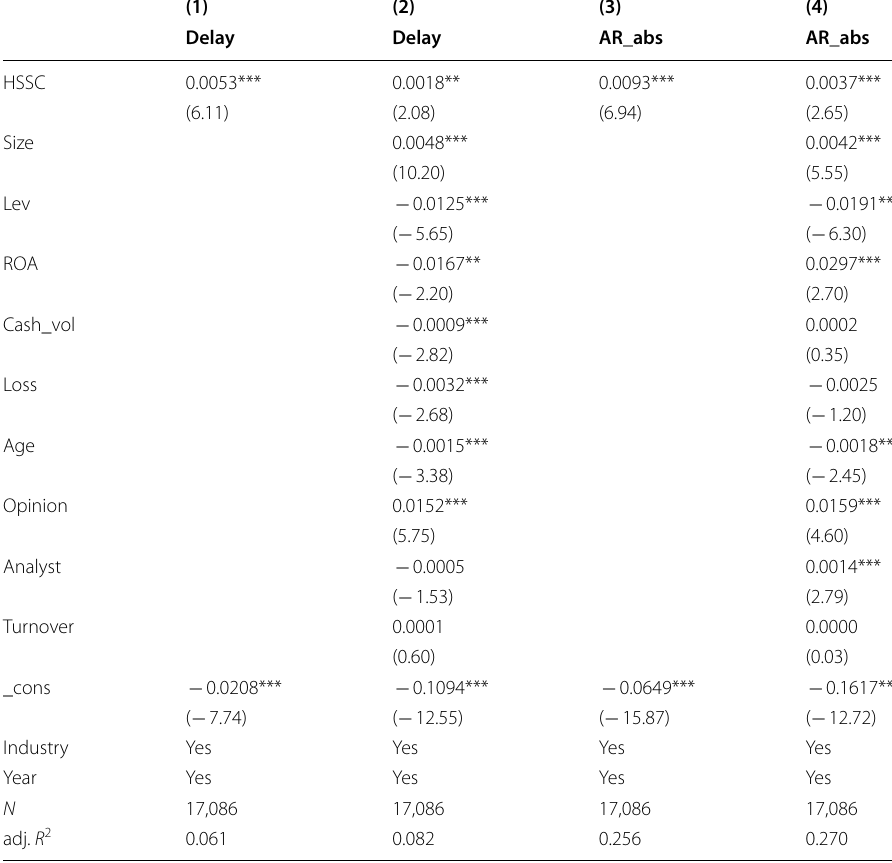
Table 9 Robustness checks: alternative measures of market